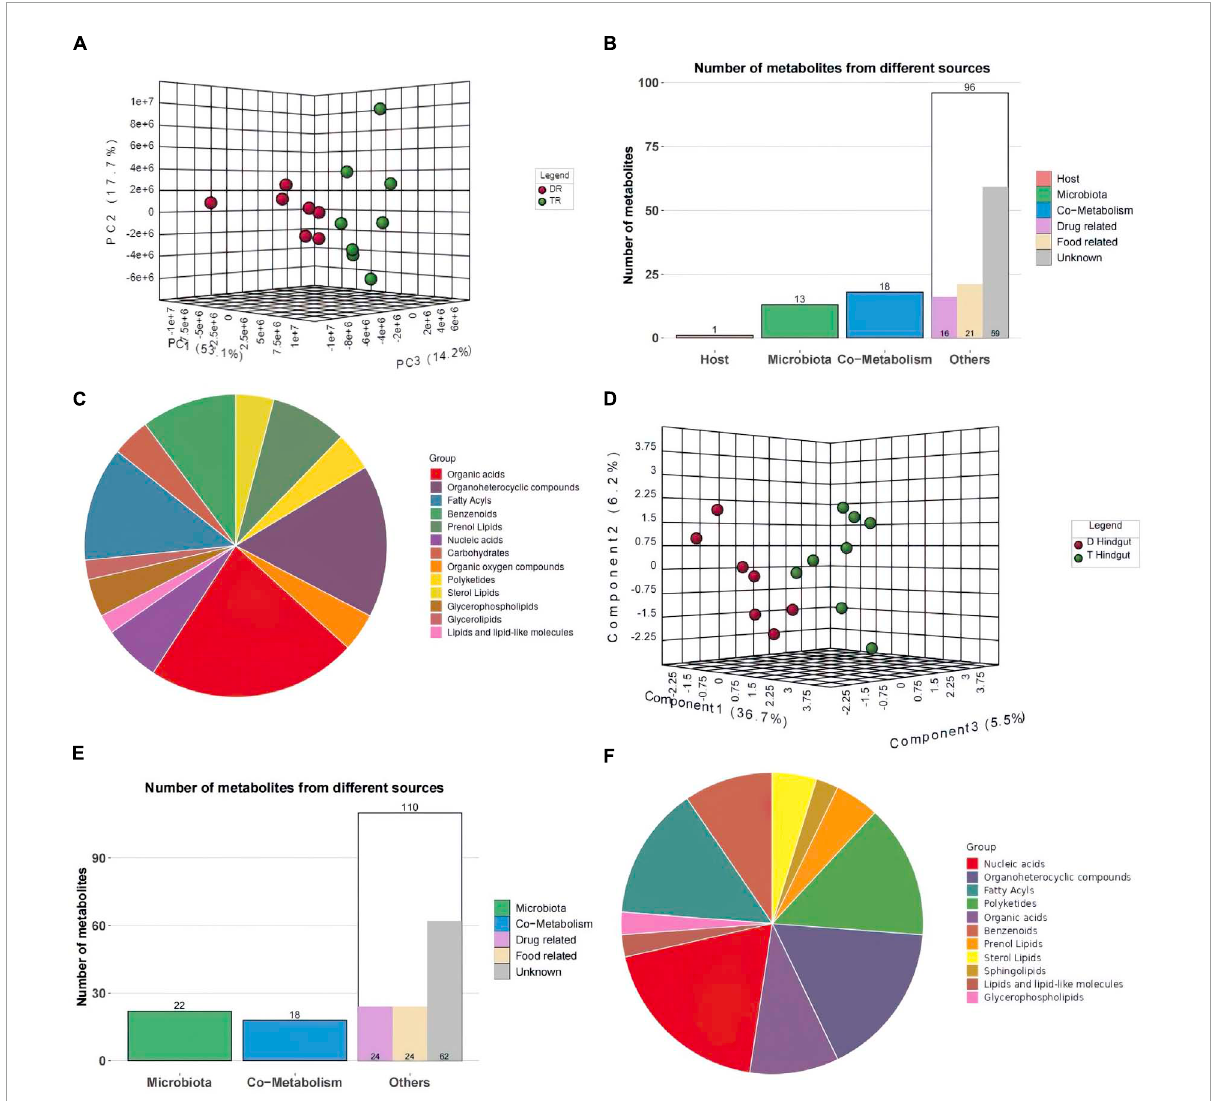
FIGURE5 Metabolome Statistics Analysis (A,D) Three-dimensional principal component analysis of the rumen and hindgut metabolome. (B,E) Classification of rumen and hindgut differential metabolite sources according to host source, microbial source and common source. (C,F) Chemical structure analysis of rumen and hindgut differential metabolites according to super